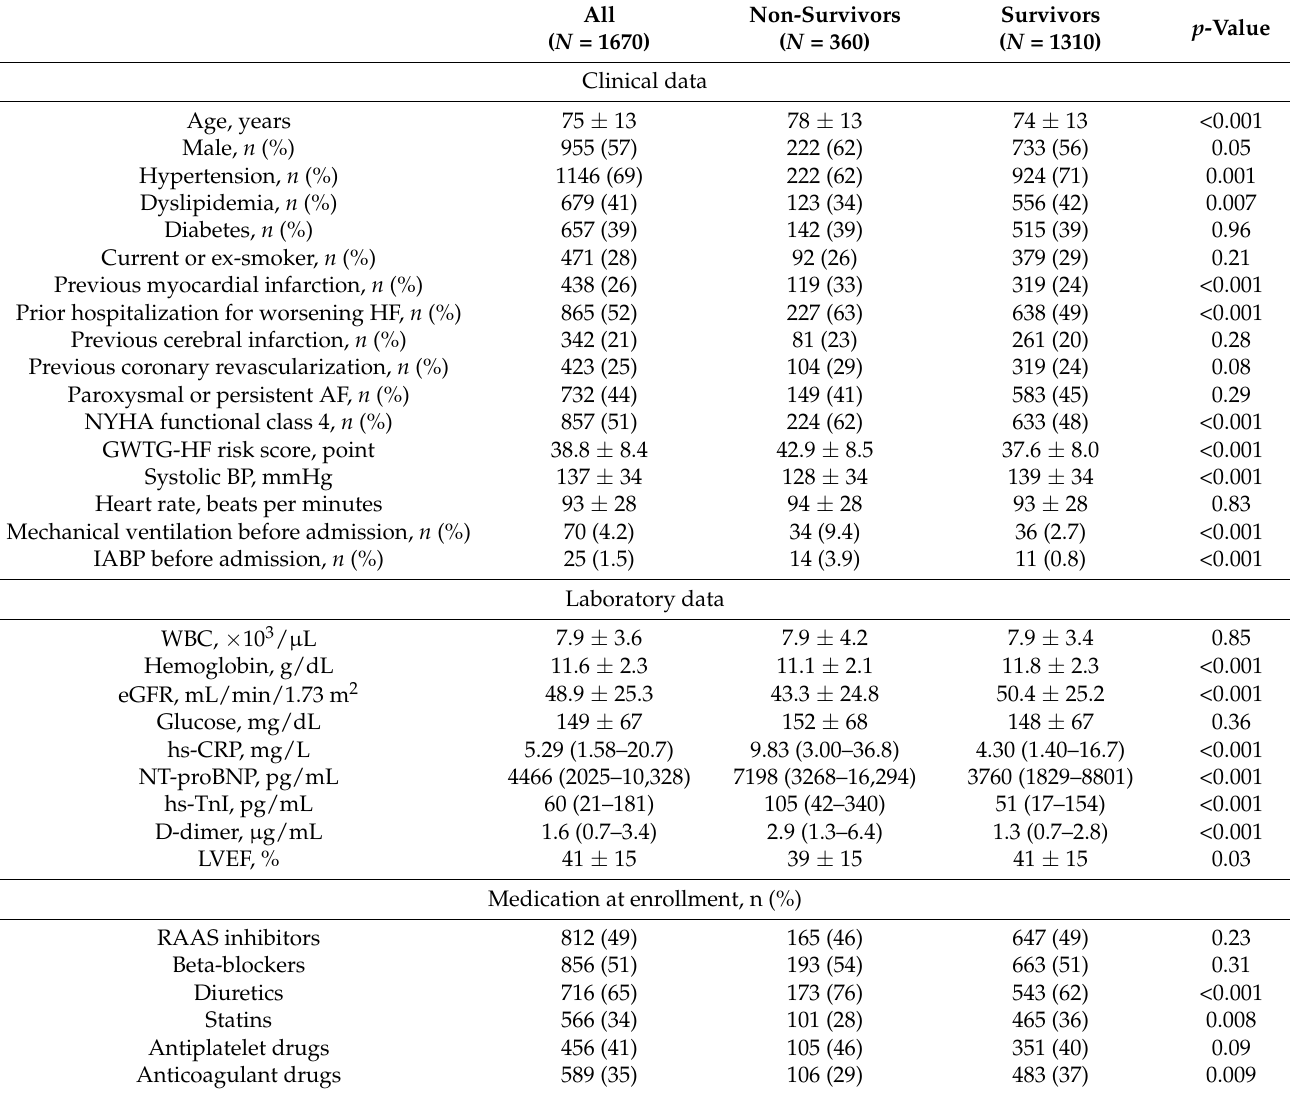
Table 1. Baseline characteristics of survivors and